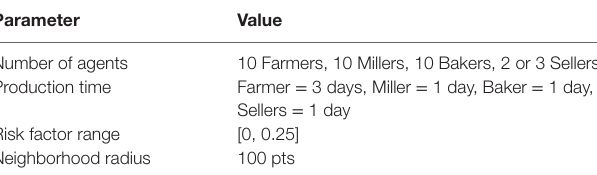
TaBle 3 | initial conditions for experiment